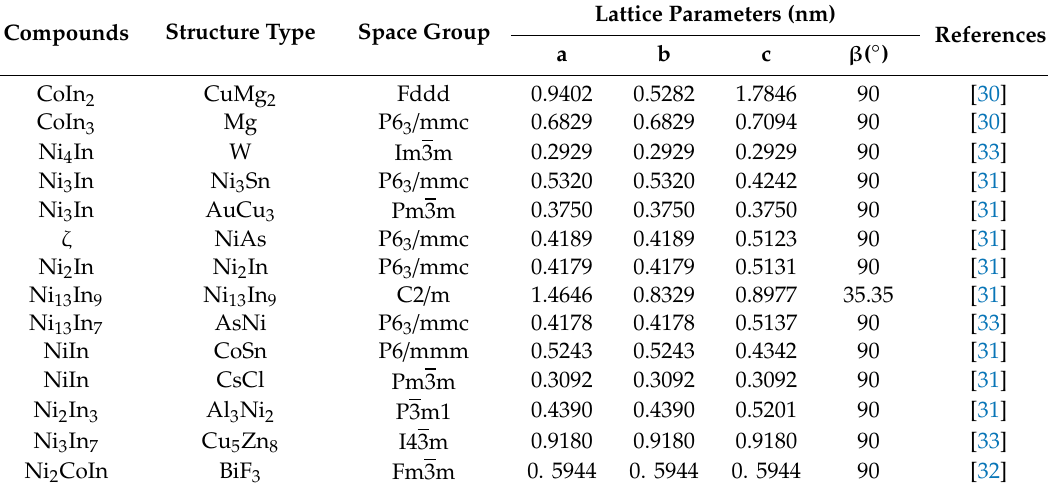
Table 1. Crystallographic data of the compounds in the Co-Ni-In